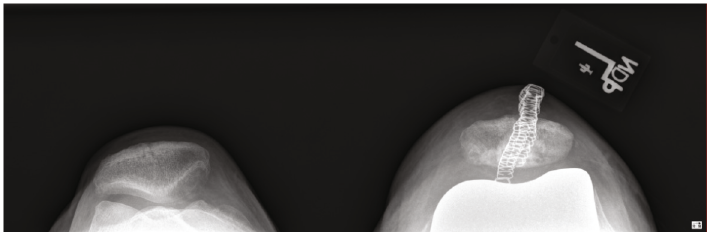
Figure 6: Postop merchant knee X-ray.